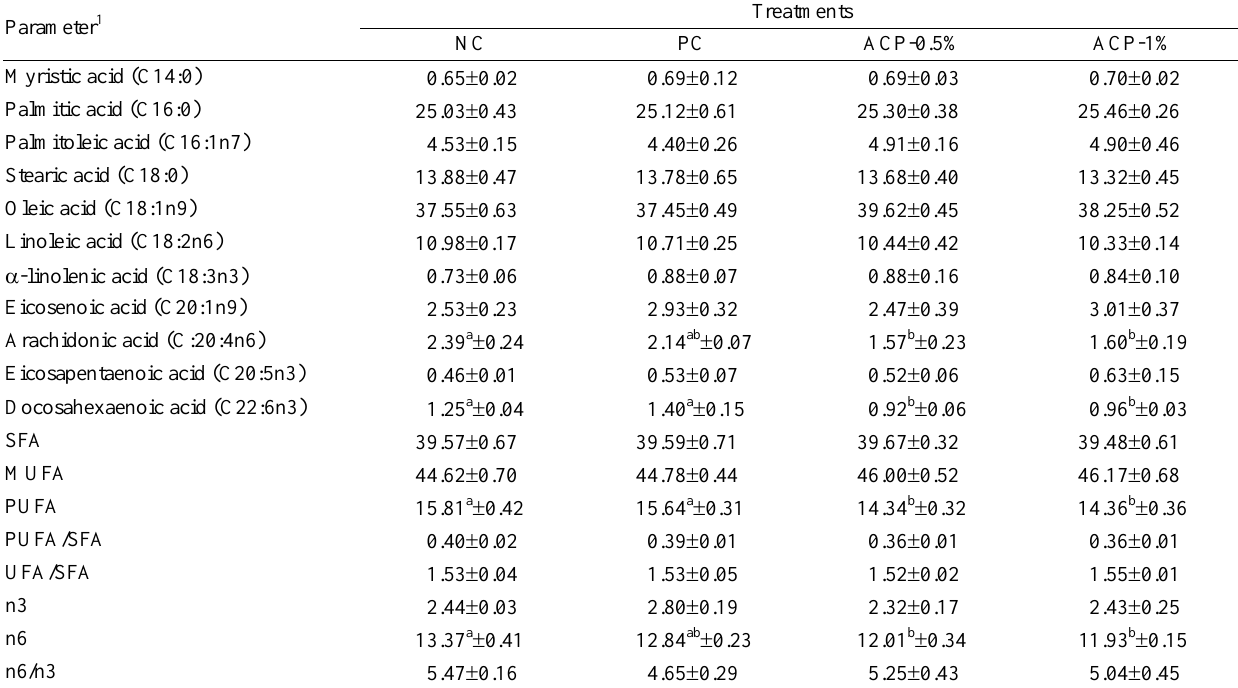
Table 6. Effect of Alisma canaliculatum with probiotics on fatty acid composition of breast meat (g/100 g total fat) (n = 15 for each treatment) Parameter